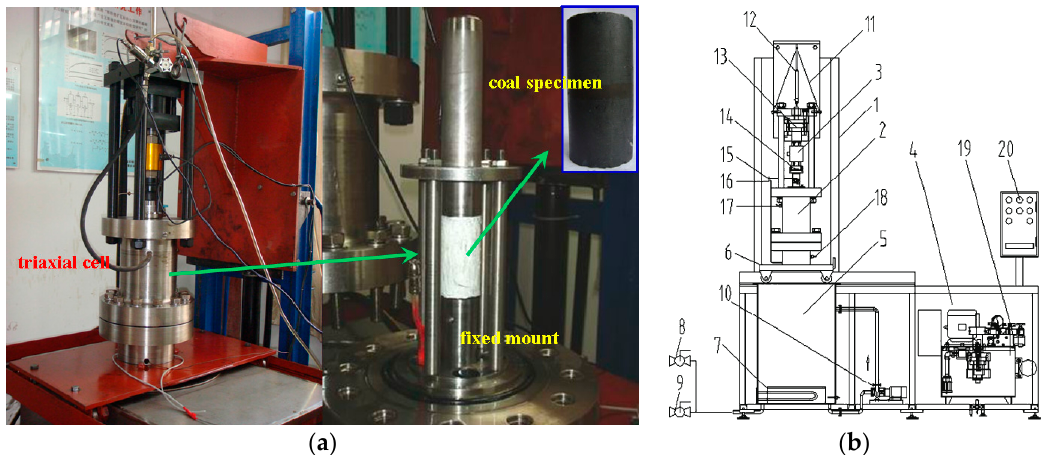
Figure 1. Apparatus and specimen installation: ( a ) photo of the apparatus; ( b ) schematic of the